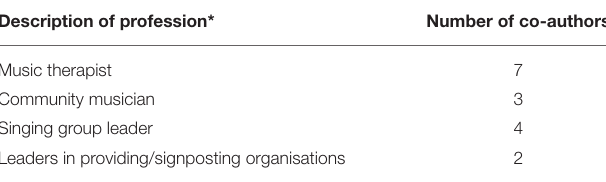
TABLE 1 | Professions of co-authors involved in the